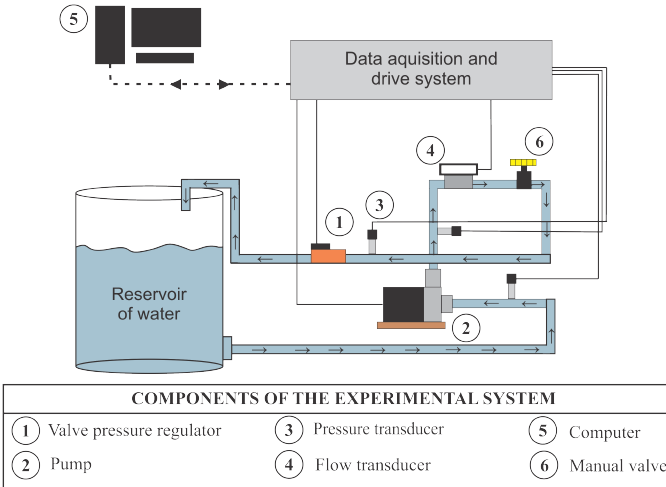
Figure 2. Scheme for carrying out tests and building the